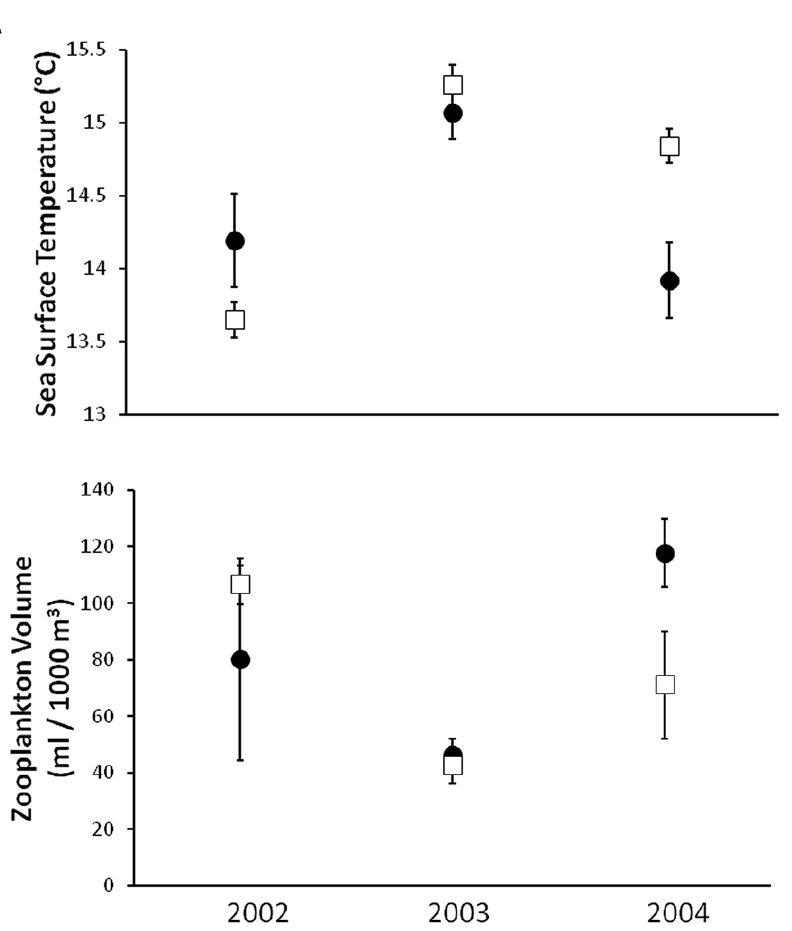
Figure 2. Interannual environmental variation at both scales. (A) Mean ( 6 2SE) sea surface temperature; (B) Zooplankton volume. The filled circles are from the CCA and the open squares from the CalCOFI sample domains.